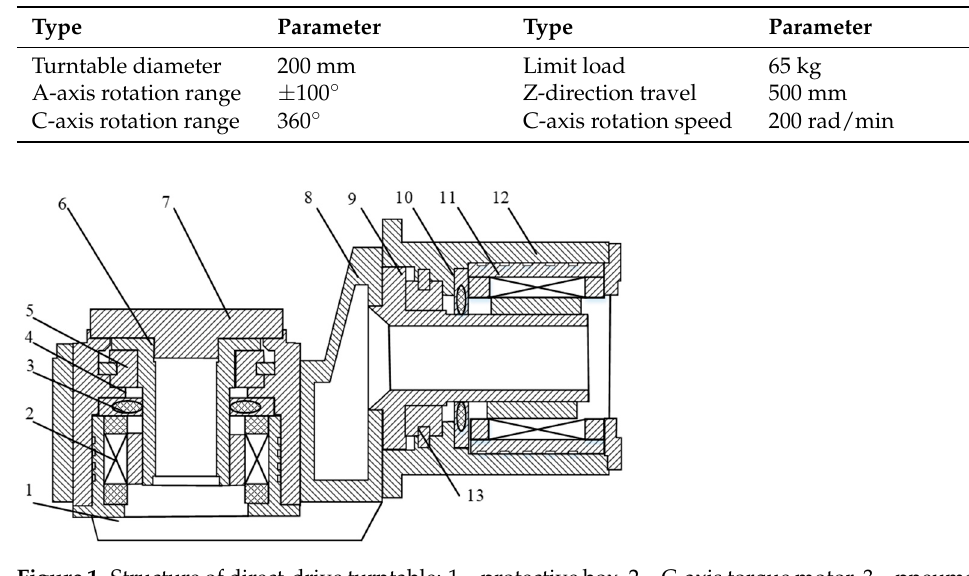
Table 1. Key design parameters of direct-drive turntable.